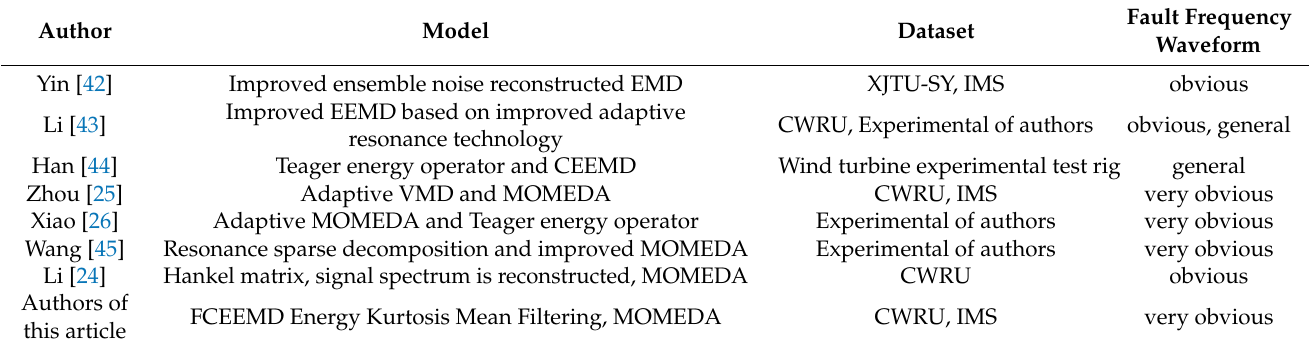
Figure 26. The envelope spectrum obtained by the proposed method under different noise levels. ( a ) Envelope spectrum at noise level SNR = 10 dB. ( b ) Envelope spectrum at noise level SNR = 15 dB. ( c ) Envelope spectrum at noise level SNR = 20 dB. ( d ) Envelope spectrum at noise level SNR = 25 dB.